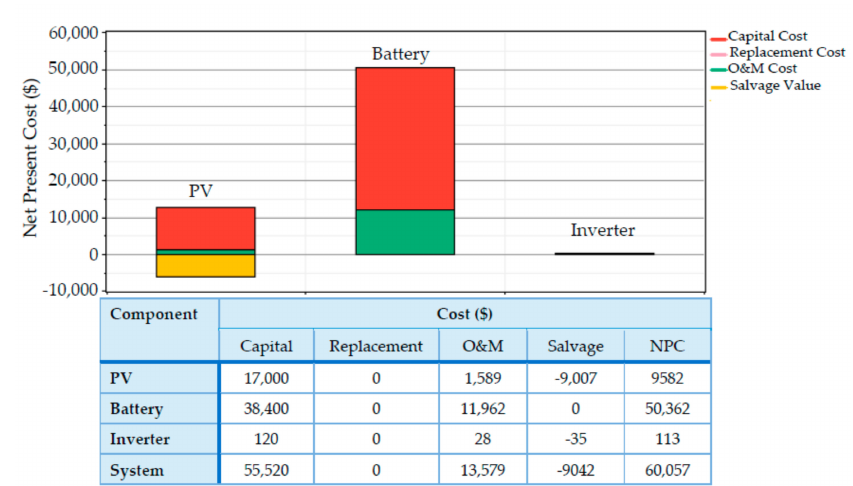
Figure 9. Summary of the net present cost for the system’s components.